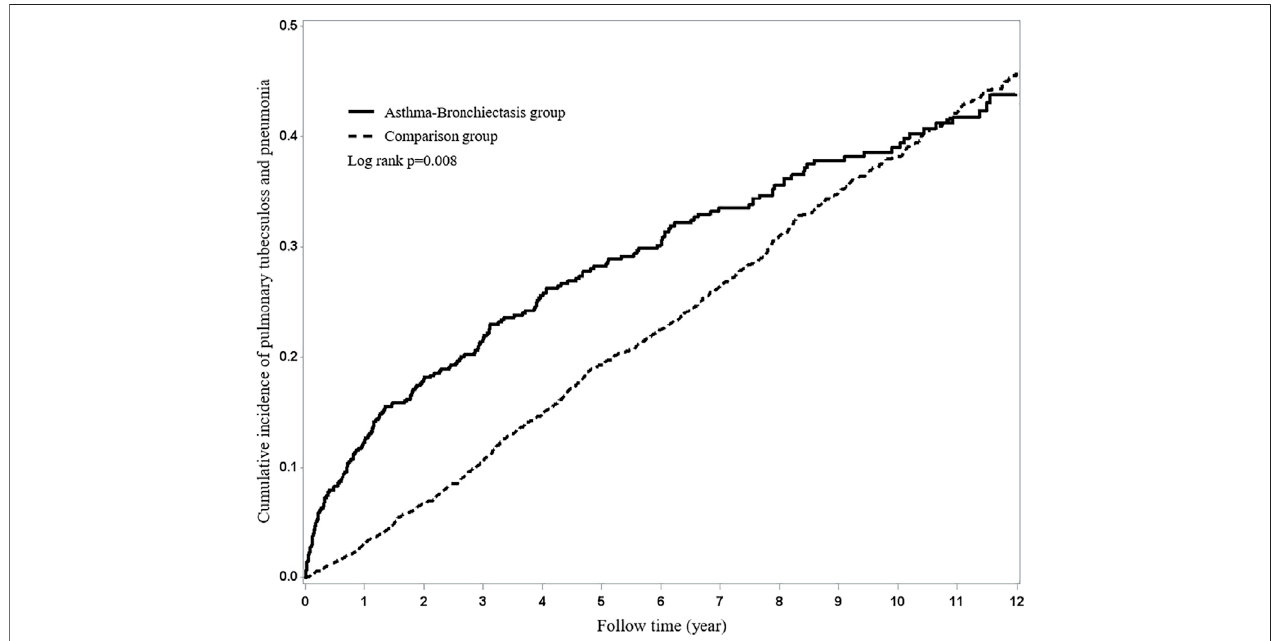
FIGURE 1 | Using Kaplan – Meier survival statistics, the crude overall survival curves with and without bronchiectasis – asthma cohort are shown (log-rank p < 0.0001).